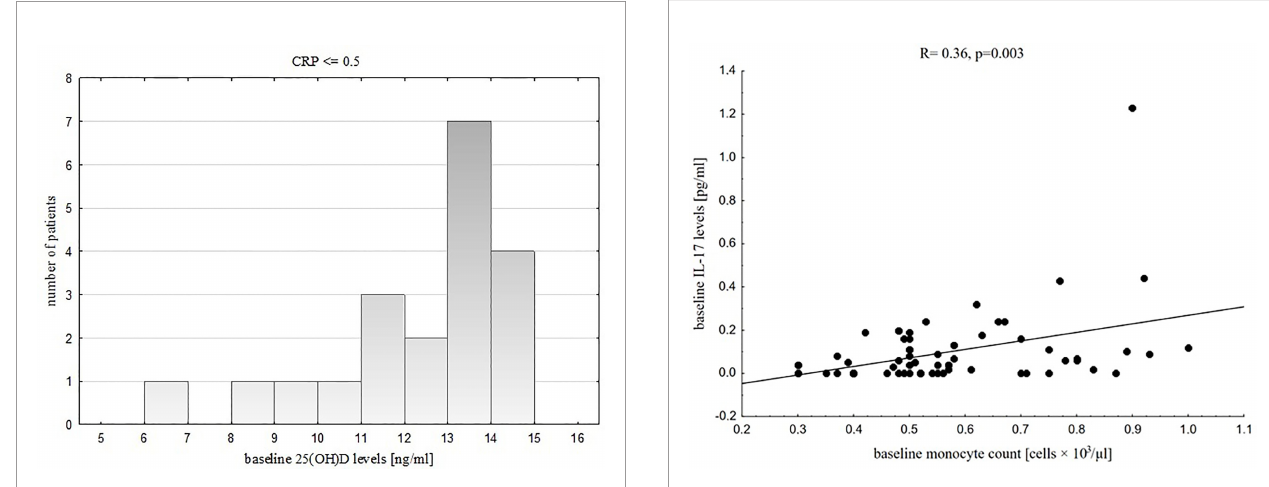
FIGURE 4 | Correlation between baseline IL-17 levels and baseline monocyte count in the whole study group.